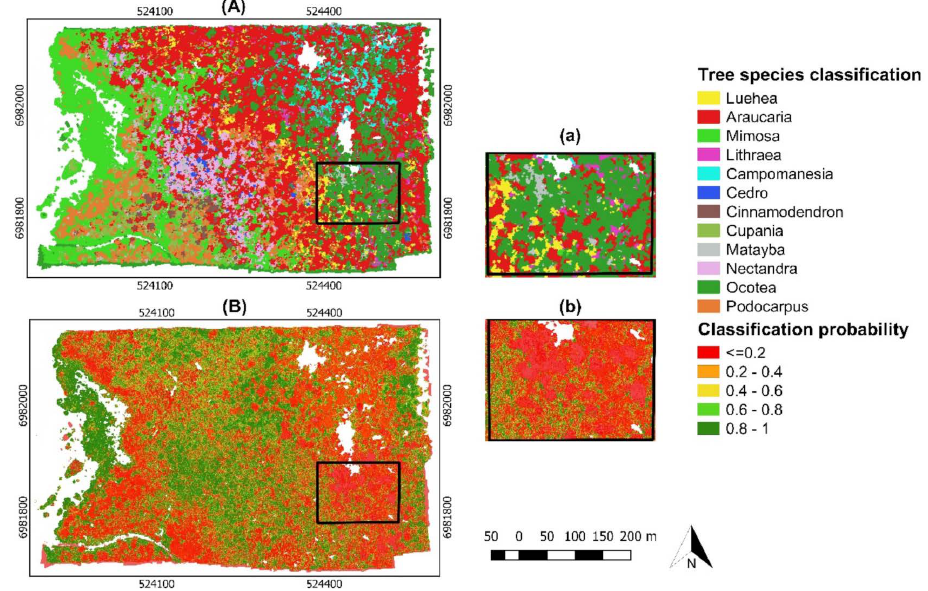
Figure 6. Classified ( A ) and probability map ( B ) with VNIR_CHM_PPC_VI dataset. Zoom ( a , b ) demonstrate a high uncertainty area classified as Ocotea